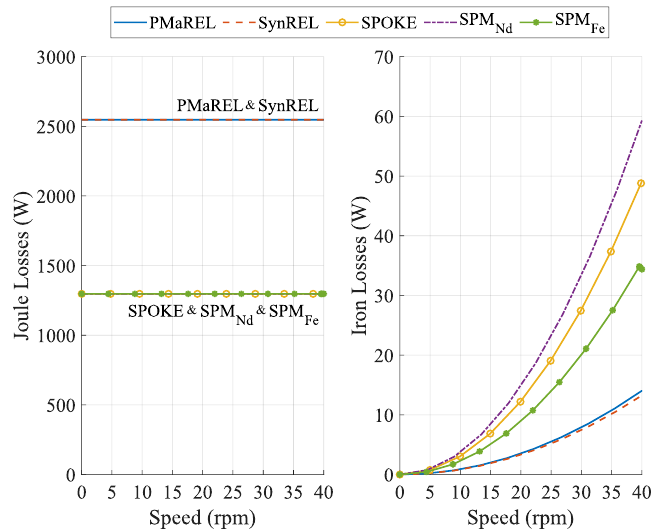
Figure 11. Losses of all motors according to